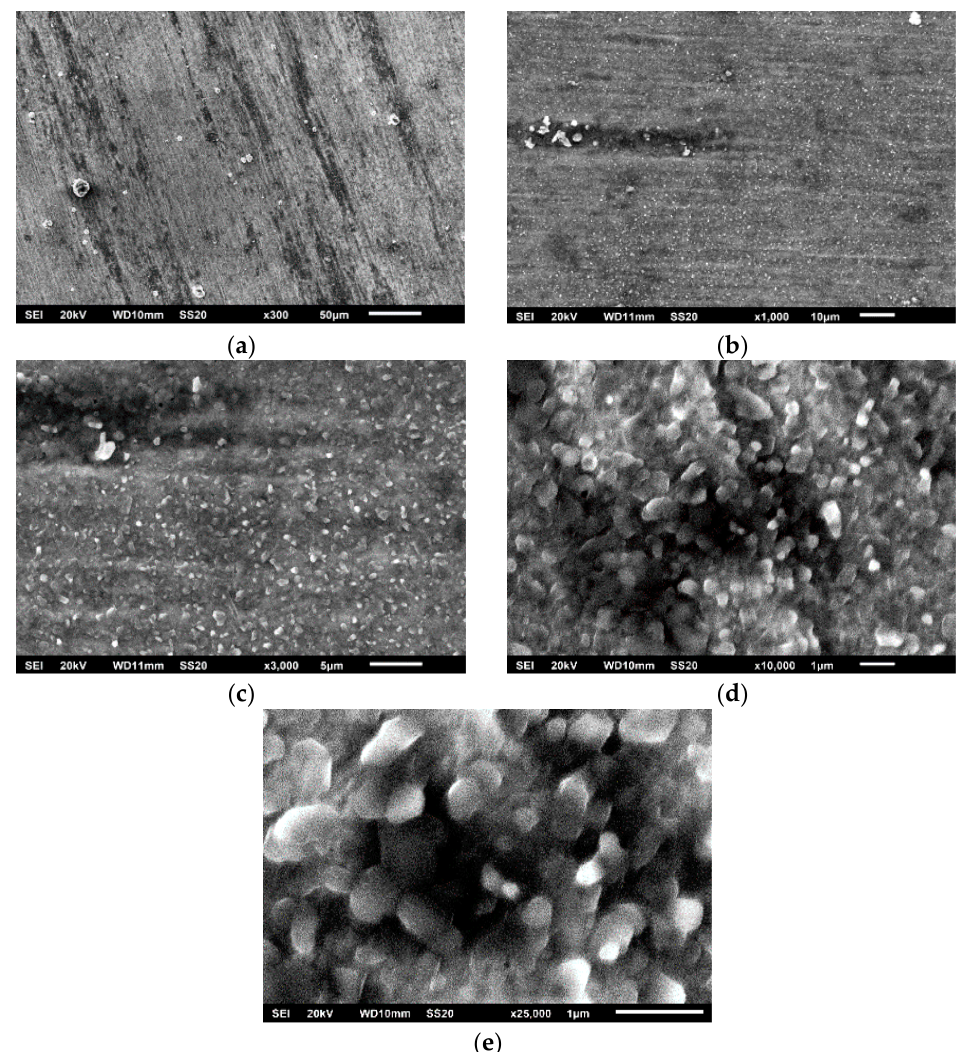
Figure 3. SEM images of the Fe-Cr-Al foil surface at different magnifications after heating at 900 °C for 10 h: ( a ) 300 times, ( b ) 1000 times, ( c ) 3000 times, ( d ) 10,000 times, ( e ) 25,000 times.